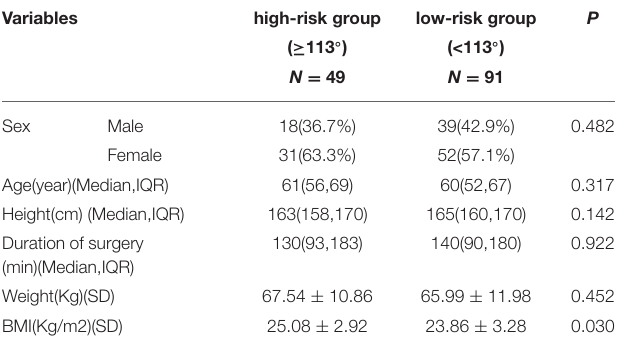
TABLE 3 | Comparison of baseline characteristics between the high- and low-risk groups in Angle A. Variables